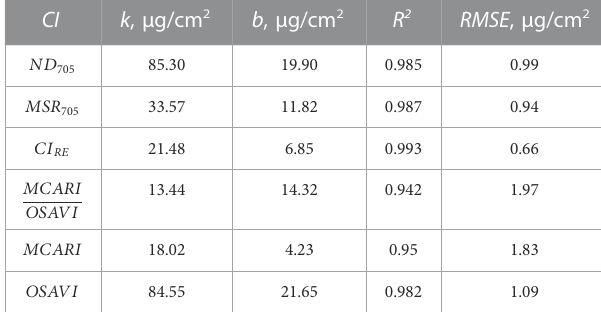
TABLE 4CIs withthe highest R 2 values (Figure5) andLAI-free CC measurement capability demonstrated for different crops. Chlorophyll index Inspected crop